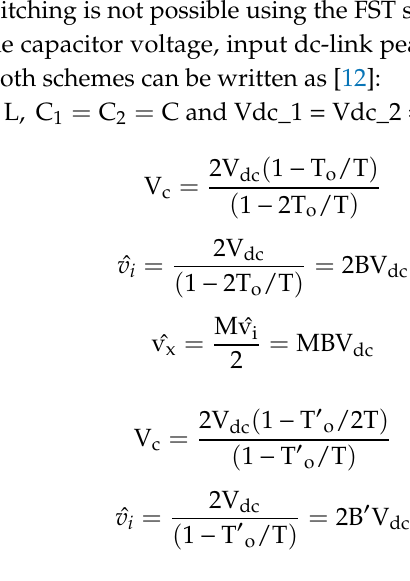
Figure 8. Three-level ZSI using a single impedance network.